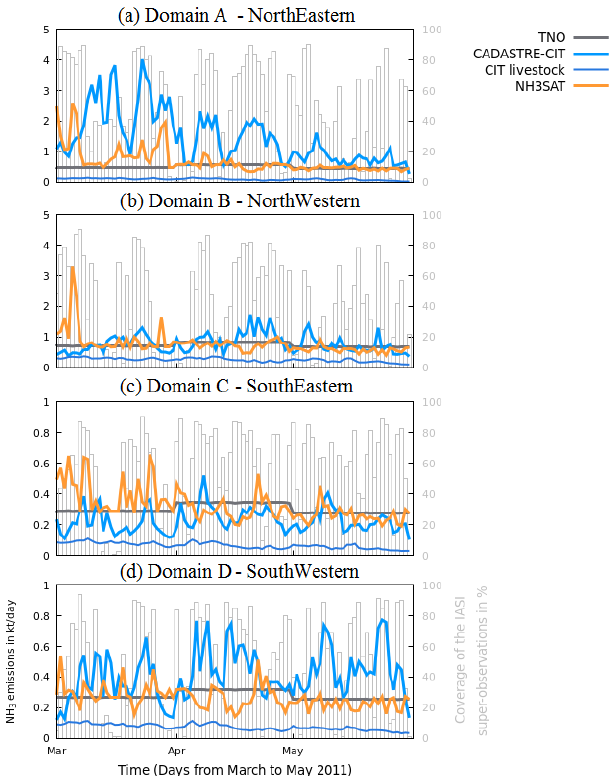
Figure 5. Time series of monthly NH 3 emissions estimated by TNO-GEN (in black), by NH 3 SAT (in orange) and by CADASTRE-CIT (in blue) inventories, from February to May 2011, for (a) domain A (northeastern), (b) domain B (northwest- ern), (c) domain C (southeastern) and (d) domain D (southwestern), as defined in Fig. 2. The contribution of the emissions due to live- stock in the CADASTRE-CIT monthly budgets is also given. Units are kilotons of NH 3 per month (ktNH 3 month − 1 ). The monthly re- gional coverage of the IASI super-observations is given in percent- age (in grey).